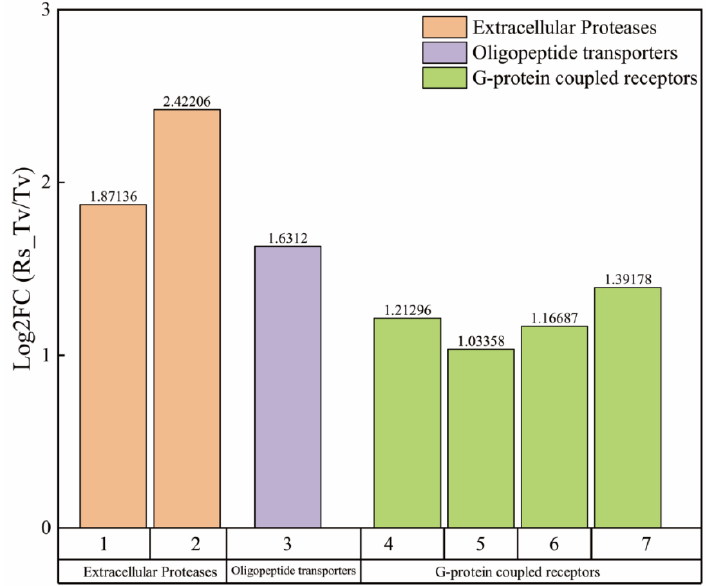
Figure 6. Genes related to recognition and signal transduction in mycoparasitic process of T. virens ZT05. 1, 2, 3, 4, 5, 6, and 7 represent TRIVIDRAFT_81735, TRIVIDRAFT_63956, TRIVIDRAFT_58191, TRIVIDRAFT_35938, TRIVIDRAFT_30459, TRIVIDRAFT_59177, TRIVIDRAFT_138511, respectively.